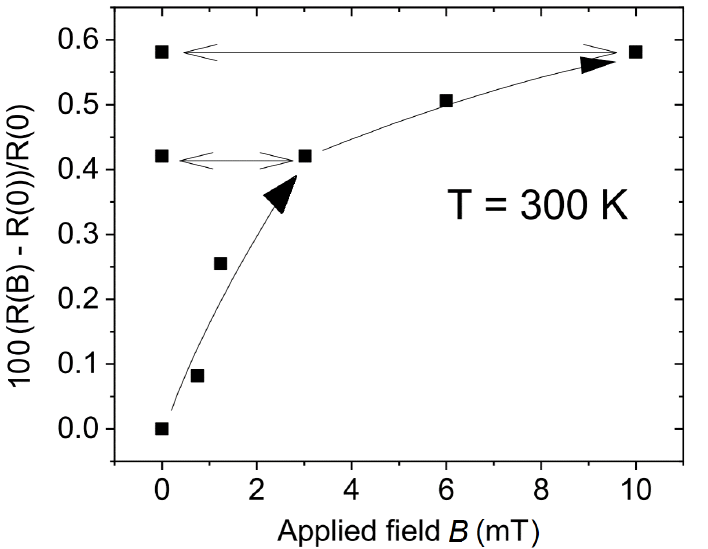
Figure 2. Field dependence of the normalized resistance at 300 K of a natural graphite sample from the same batch as the one used for MFM. Black squares represent the experimental data and the lines are only a guide for the eye. The field is applied perpendicular to the SFs and graphene planes of the sample. The arrows indicate the sweep field direction. Note that the values of the magnetoresistance reach ∼ 0.6% at 10 mT. With the LR700 resistance bridge we have used, the relative error of each of the resistance points is (cid:46) 2 × 10 − 4 R(0). Similar results were reported in